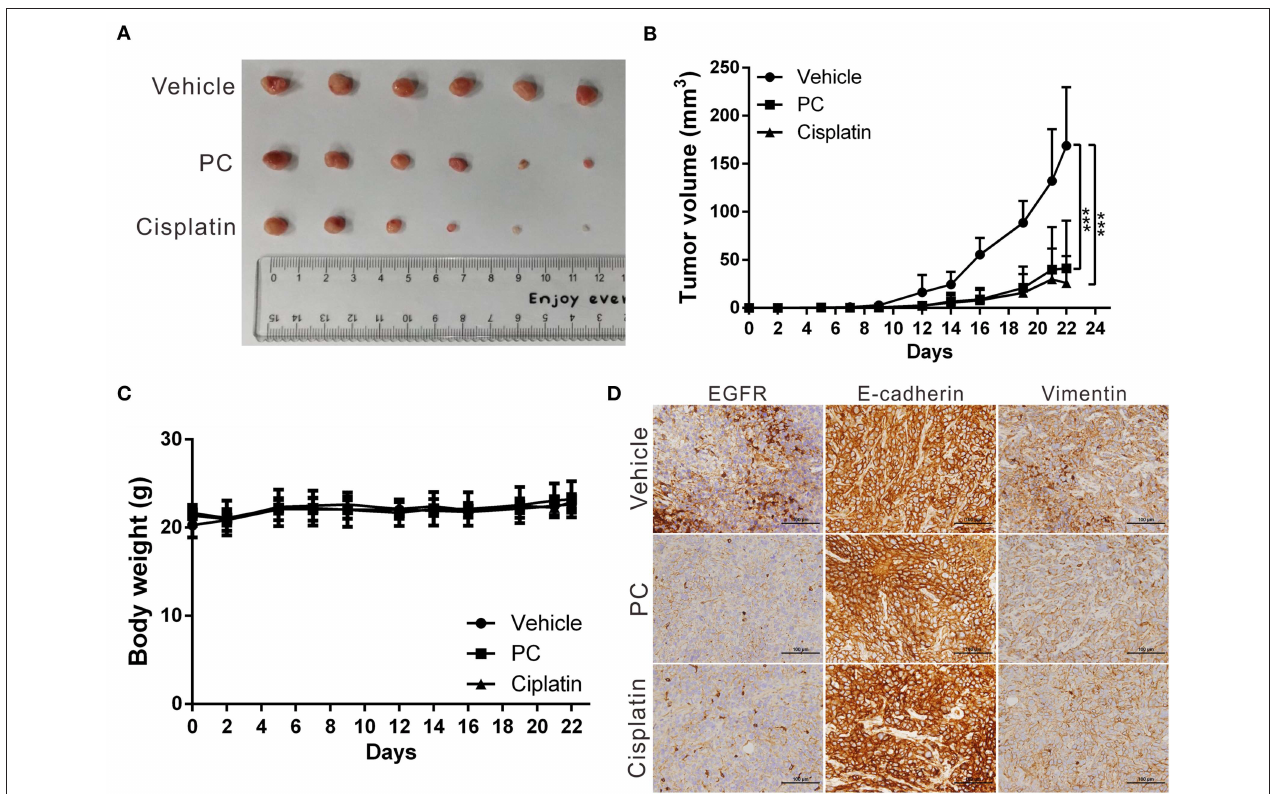
FIGURE 5 | Psorachromene inhibits tumor growth in mice. (A) A total of 5 × 10 6 SAS cells were inoculated into nude mice ( n = 6). Representative images show the tumor xenografts at 3 weeks after implantation. Psorachromene significantly reduced tumor growth. (B) Tumor volumes were calculated every 3 days after injection. The volume of each tumor was calculated as follows: length × width 2 × 0.5. Bars indicate S.D. *** p < 0.001. (C) Body weights were calculated every 3 days after injection. (D) Immunohistochemical staining represents the effect of psorachromene on the expression of EGFR and EMT associated proteins in mice xenograft tumors. Magnification: 400 ×